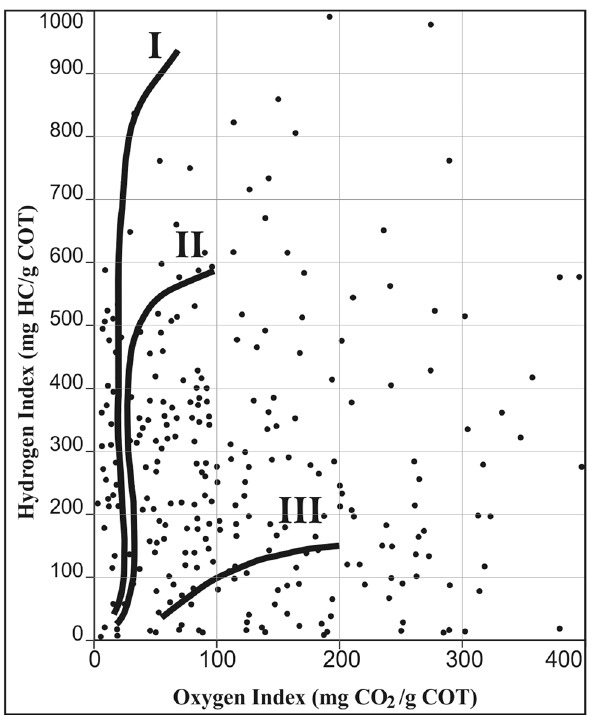
Fig. 4 HI/OI diagram showing the representative points of samples from Bir M’Cherga Aptian–Albian source rocks (Corel Draw figure exported into jpeg